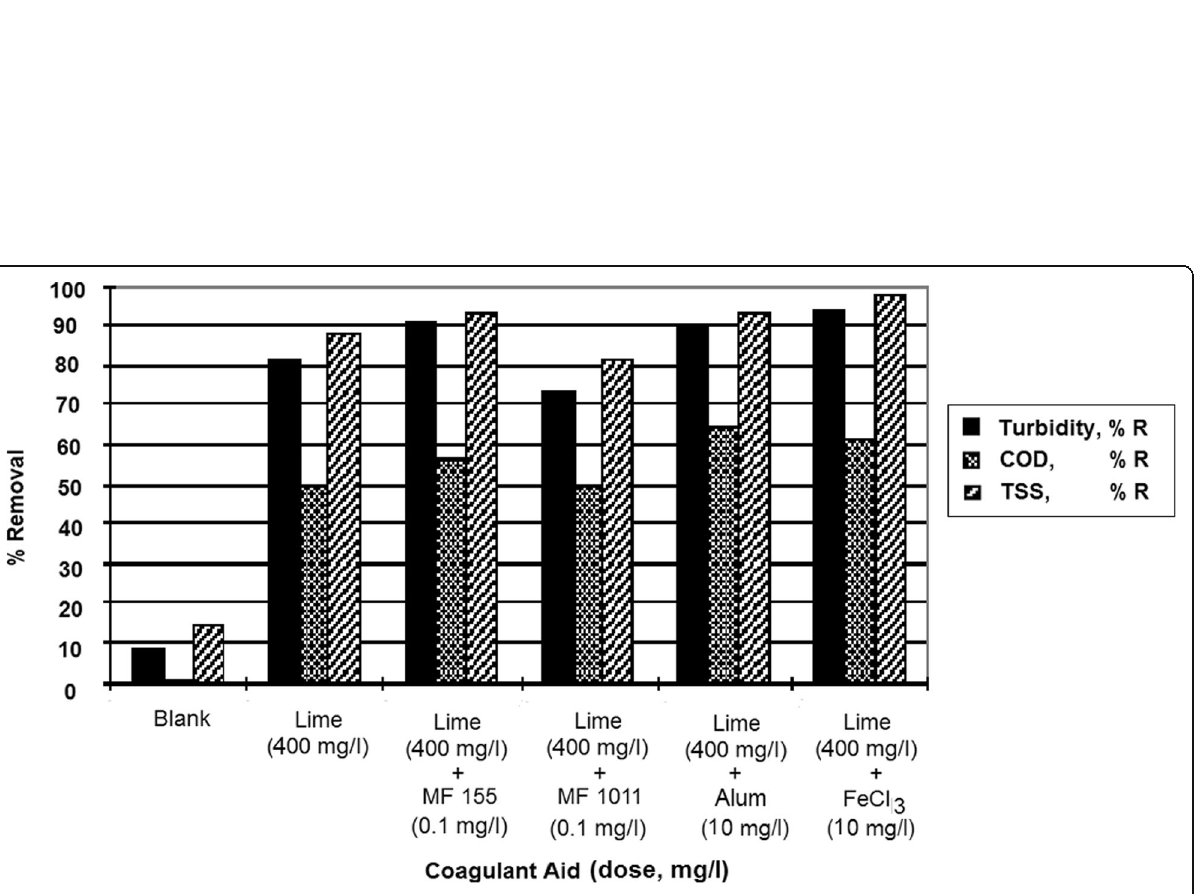
Fig. 3 Comparison between the use of Lime alone and in combination with coagulant aids and other